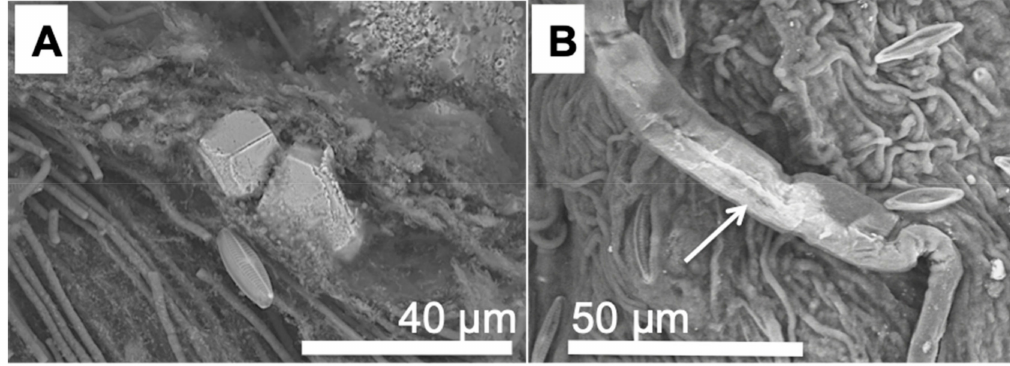
Figure 6. SEM images of ( A ) rhombic sparite crystals wrapped in EPS and ( B ) a thin sheet (white arrow) of carbonate precipitated directly on the surface of a Phormidium -like